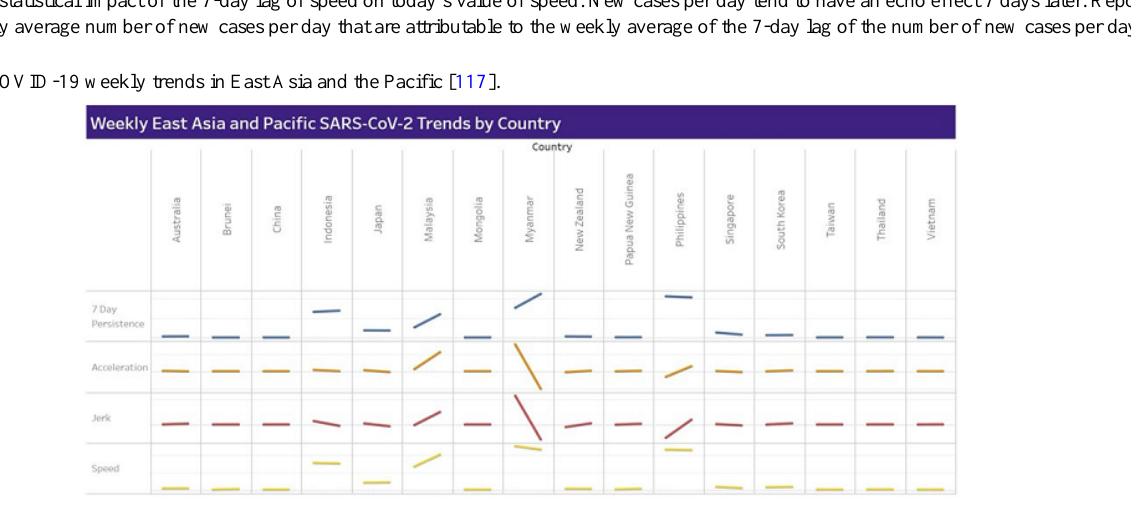
Table 2, for the week of October 5-11, and Table 3, for the week of October 12-18, present traditional surveillance metrics including new COVID-19 cases, cumulative COVID-19 cases, 7-day moving average of COVID-19 infections, infections per 100,000 population, deaths, cumulative deaths, and 7-day moving average of deaths rates per 100,000 population. Overall, in East Asia and the Pacific, by the second week, there were 9951 new daily cases of COVID-19, 1,076,042 cumulative cases of COVID-19, a 7-day moving average of 8005, an infection rate per 100,000 population of 0.4344, 216 daily deaths, and 28,053 cumulative deaths.